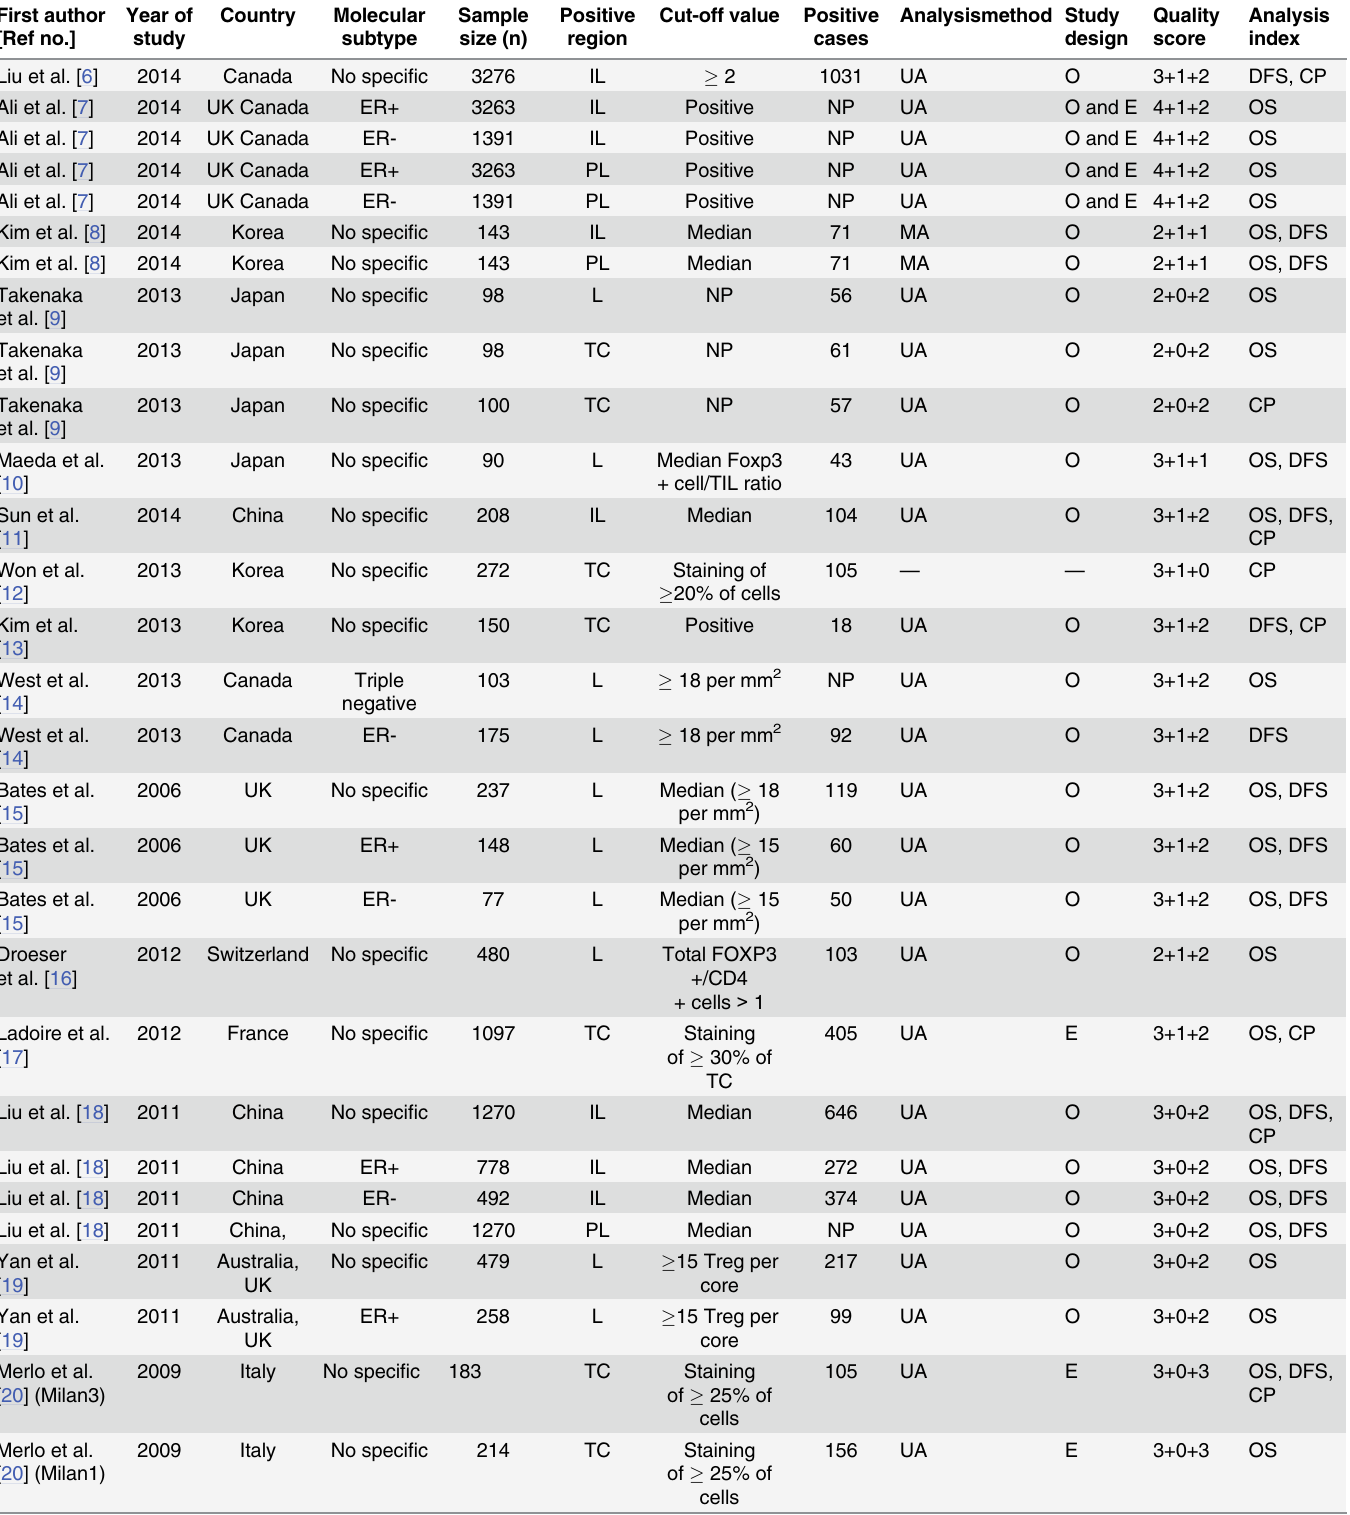
Table 2. Main characteristics of the included